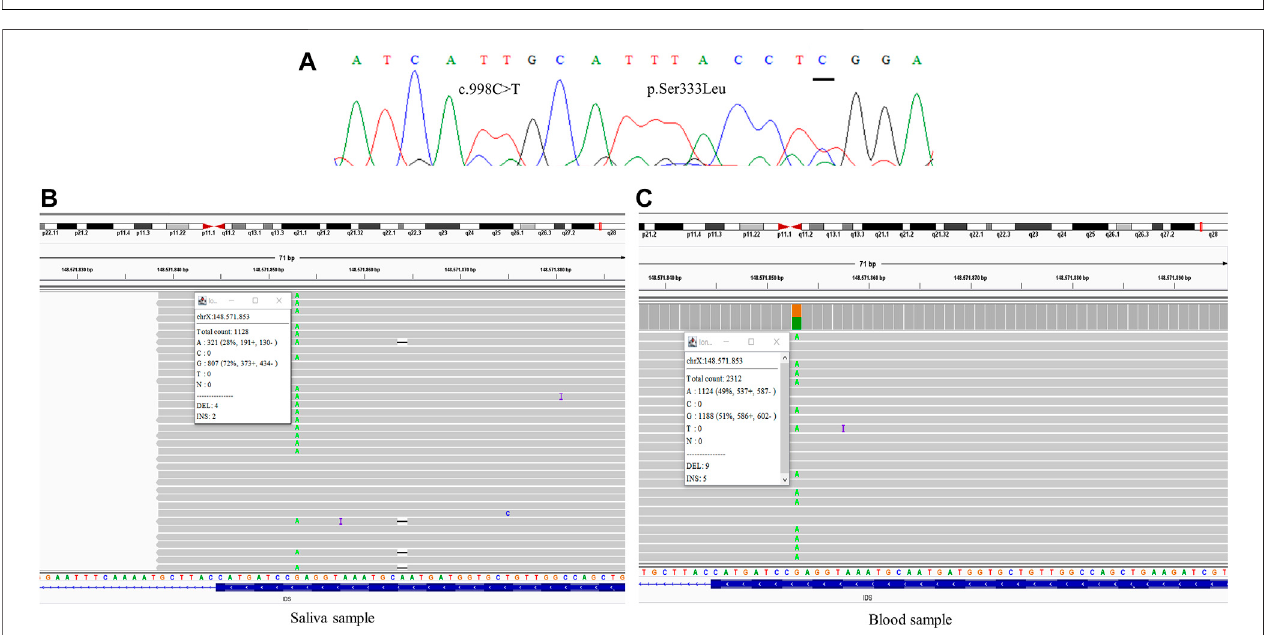
FIGURE3| ComparativeresultsofsangersequencingandNext-generationsequencingatthemutationlocusc.998C > T( p .Ser333Leu) (A) Sangersequencing (B) Next-generation sequencing showing the coverage of the locus of the mutation in saliva sample, at a frequency of 28% (C) Next-generation sequencing showing the coverage of the locus of the mutation in blood sample, at a frequency of 49%.